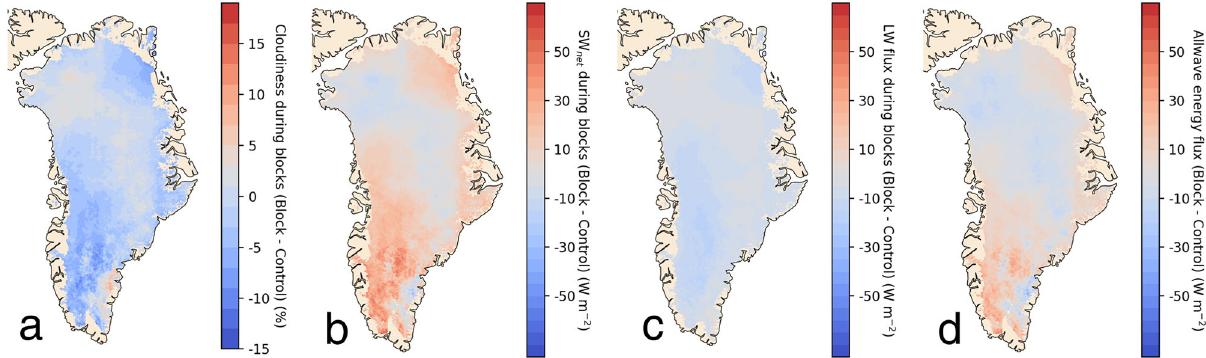
Fig. 3 Radiative effects of all summer atmospheric blocking events on the surface of the Greenland Ice Sheet relative to mean (2003 – 2020) conditions. ( a ) cloudiness; ( b ) net shortwave radiative fl uxes; ( c ) downward longwave radiative fl uxes; ( d ) allwave radiative fl uxes. Blocking days, which were provided by Ward et al. 25 , have a net positive (warming) effect on radiation receipt at the surface of the ablation Northwest, Northeast, and Southwest Greenland, net radiative fl uxes in the ablation zone increase by + 11.5 ± 3.1 W m − 2 ,